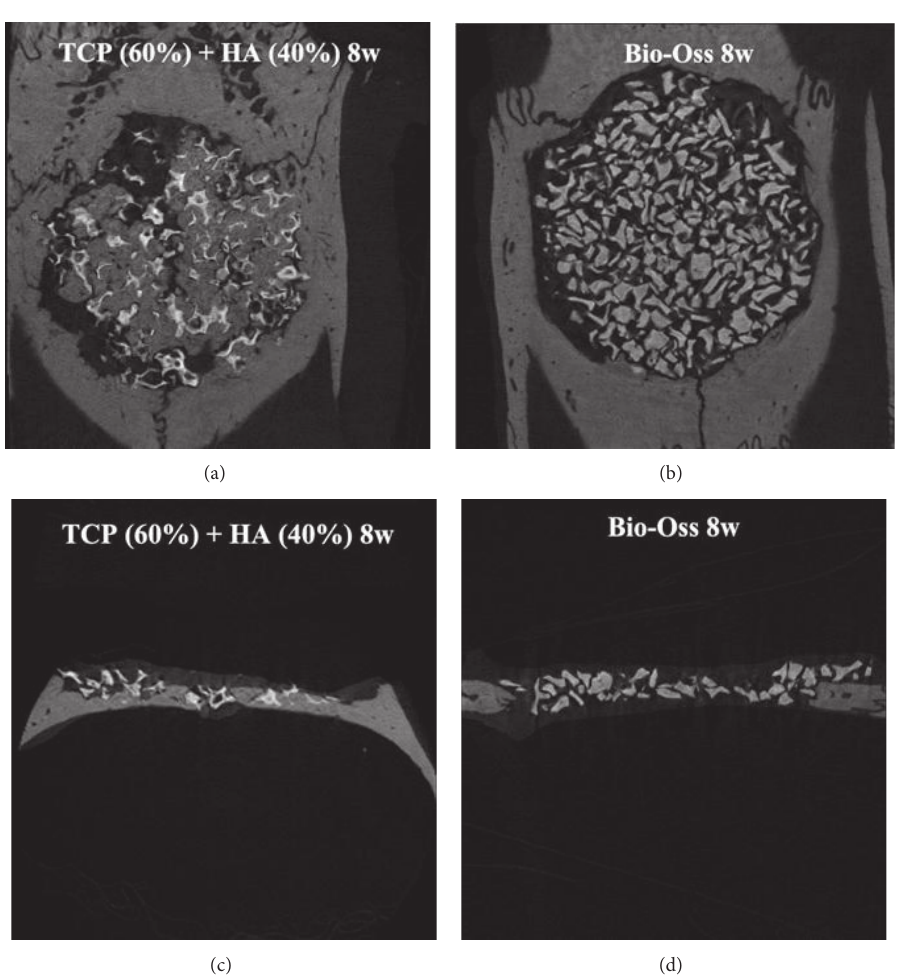
Figure 6: Micro-CT results of 60TCP40HA and Bio-Oss 8 weeks after